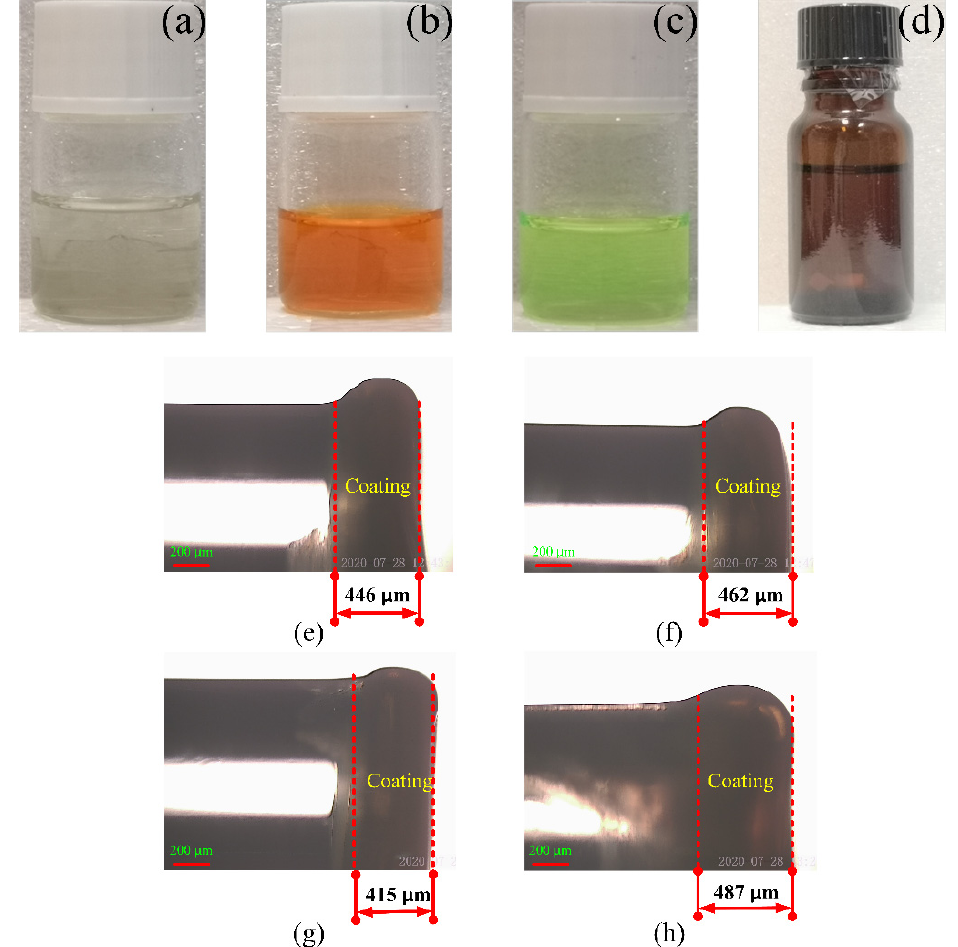
Figure 2. Chemical reagent and coating images of four optical fibers with different ruthenium concentrations ( a ) carrier matrix, ( b ) oxygen sensitive dye, ( c ) reference dye, ( d ) DO composite sensitive solution, ( e ) 0.1, ( f ) 0.2, ( g ) 0.3, and ( h ) 0.4 mg/mL.